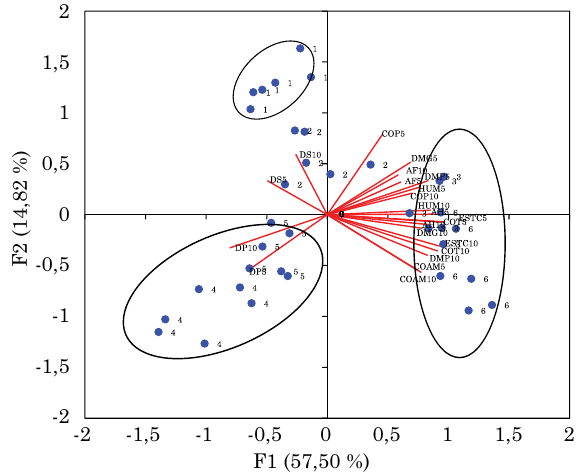
Figura 3. Gráfico bi-plot obtido a partir da análise de componentes principais (Acp) na profundidade de 0,00-0,05 e 0,05-0,10 m das características químicas e físicas do solo, após impacto ambiental. 1: Sem impacto; 2: soterramento total e cultivo de aveia+ervilhaca; 3: transbordamento do rio e cultivo de milheto+girassol; 4: transbordamento do rio e grande deposição de areia e cultivo de aveia-preta; 5: transbordamento do rio, o que ocasionou grande deposição de areia e sem cultivo; e 6: transbordamento do rio em menor escala e sem cultivo. AR: areia; ARG: argila; SIL: silte; DS: densidade do solo; DP: densidade da partícula; DMP: diamnetro médio ponderado; DMG: diâmetro médio geométrico; COT: carbono orgânico total; COP: carbono orgânico particulado; COAM: carbono orgânico mineral; AF: ácido fúlvico; AH: ácido húmico; e HUM: